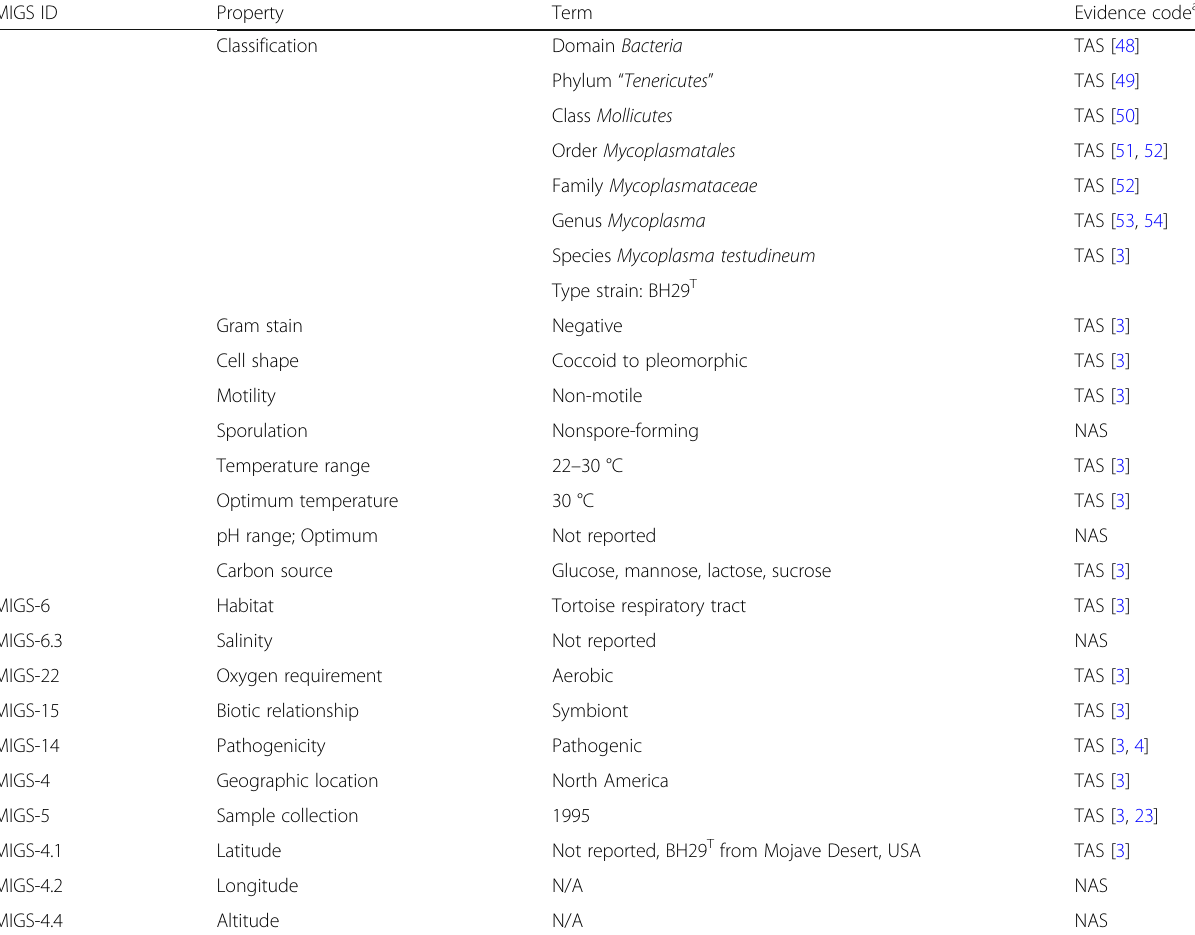
Table 1 Classification and general features of Mycoplasma testudineum strain BH29 T MIGS